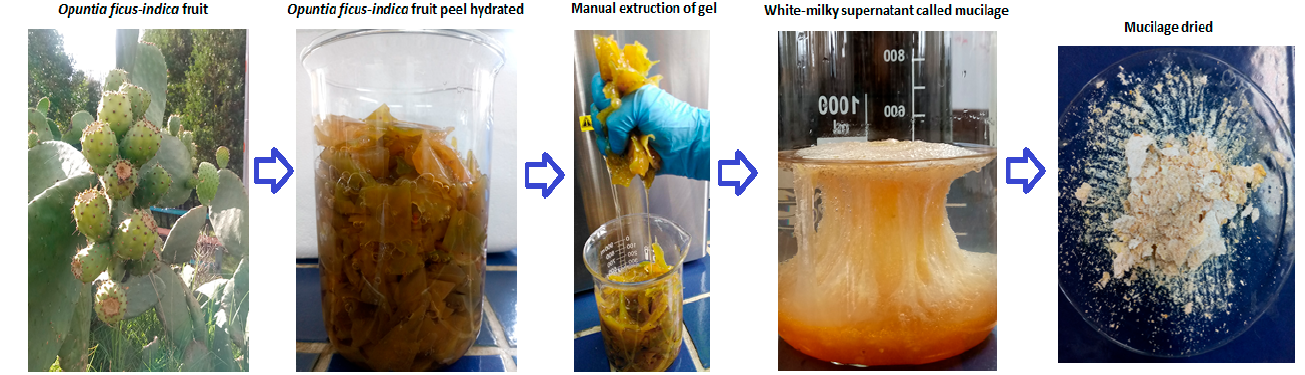
Figure 1. Selected photographs of the process of extracting mucilage from the peels of the fruit of Opuntia ficus-indica .